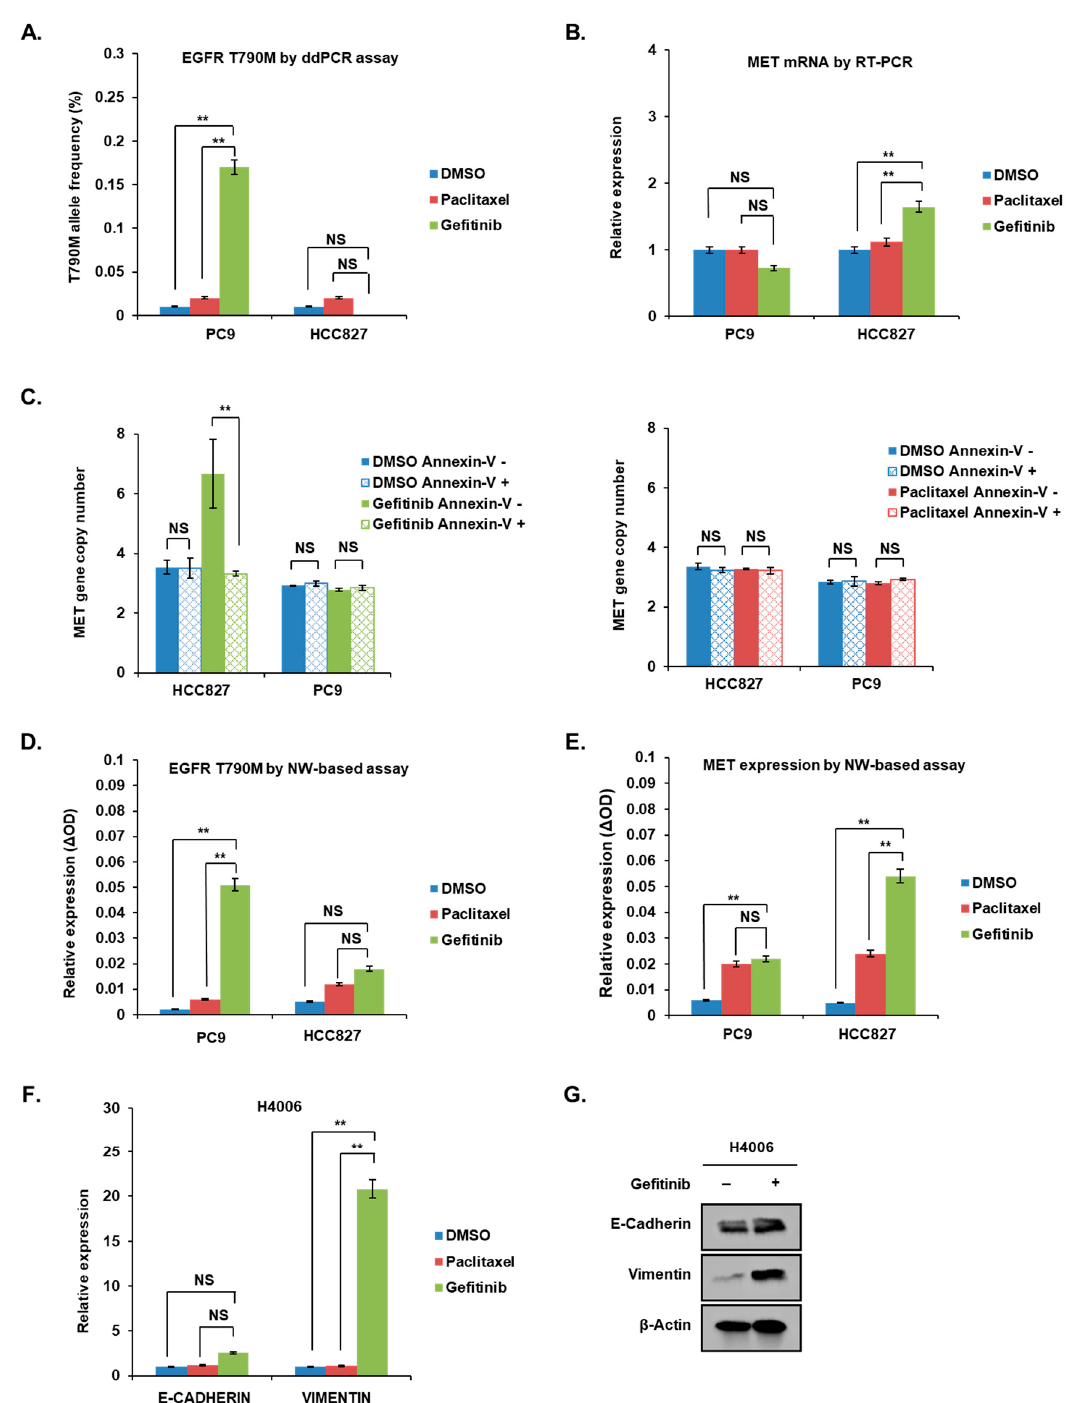
Figure 3. Expression of specific gene alterations related to EGFR-TKI resistant mechanism in different cell lines. In the parental cell lines (PC9 and HCC827), ( A ) EGFR T790M mutation levels and ( B ) C-MET mRNA expression were measured after 48 h of treatment with DMSO, gefitinib (0.1 µ M), or paclitaxel (0.1 µ M). The allele frequency of EGFR T790M mutation was calculated using the ddPCR assay. C-MET mRNA expression was measured by RT-PCR. ( C ) PC9 and HCC827 cells were sorted according to the expression levels of annexin-V-FITC and MET-Alexa 647 after 48 h of treatment with DMSO, gefitinib (0.1 µ M), or paclitaxel (0.1 µ M). The copy number of C-MET gene in each group was measured using the ddPCR assay. ( D , E ) The amount of EGFR T790M mutation